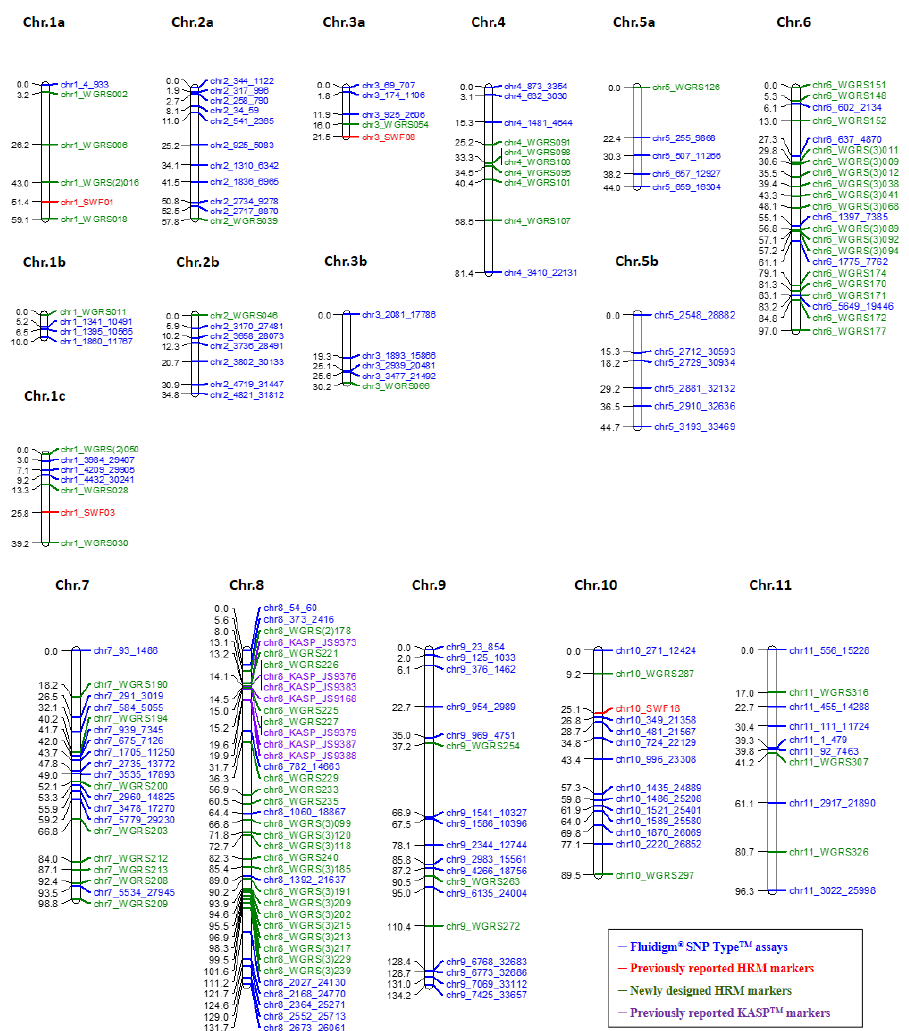
Figure 2. Genetic map of watermelon constructed by SNP markers. Numbers on the left side correspond to the genetic distance in cM from the top of each chromosome. Names on the right side indicate marker name that represents marker type according to color (blue, Fluidigm ® SNP Type™ assays; red, previously reported HRM markers; green, newly designed HRM markers; purple, previously reported KASP™